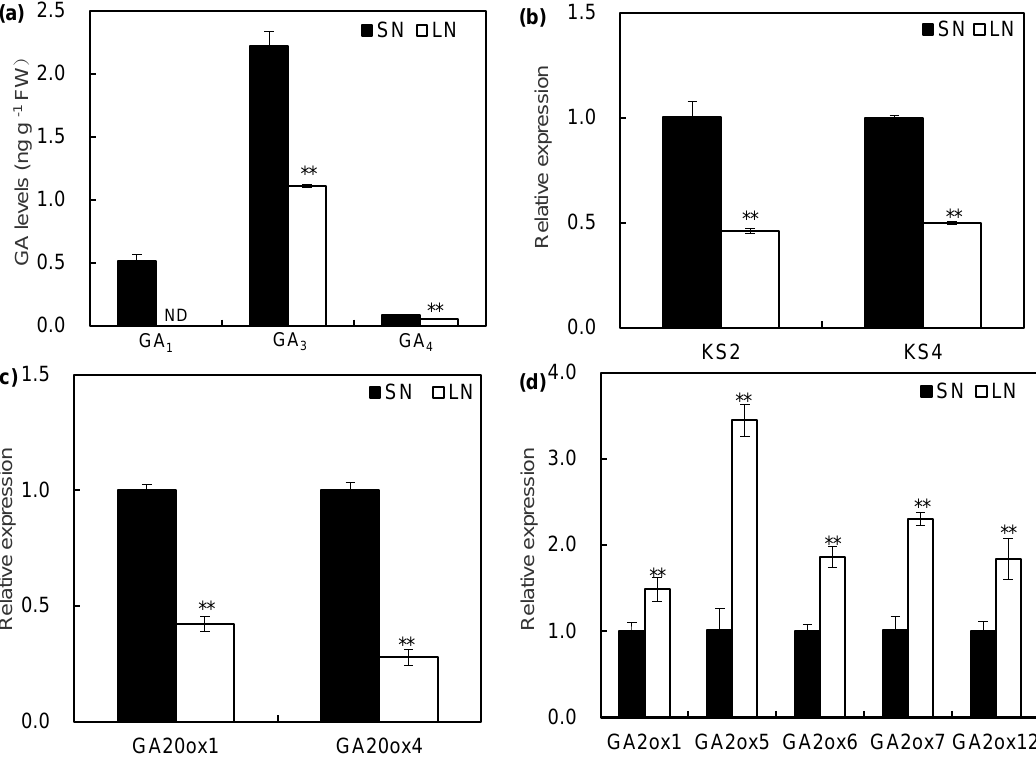
Figure 3. The GA contents and the expression levels of GA biosynthesis- and catabolic related genes in maize seedlings responded to LN and SN. ( a ) The contents of GA 1 , GA 3, and GA 4 in the wild-type roots at 5 d after LN and SN. ND: not detected. ( b – d ) The transcriptional levels of ent-kaurene synthases ( b ), GA 20-oxidases ( c ), and GA 2-oxidase ( d ) genes in the wild-type roots at 3 d after LN and SN treatment. ( a – d ) Values were the means ± SD ( n = 3). The asterisks indicated significant difference compared with the control as evaluated by Student’s t -tests ** p < 0.01.